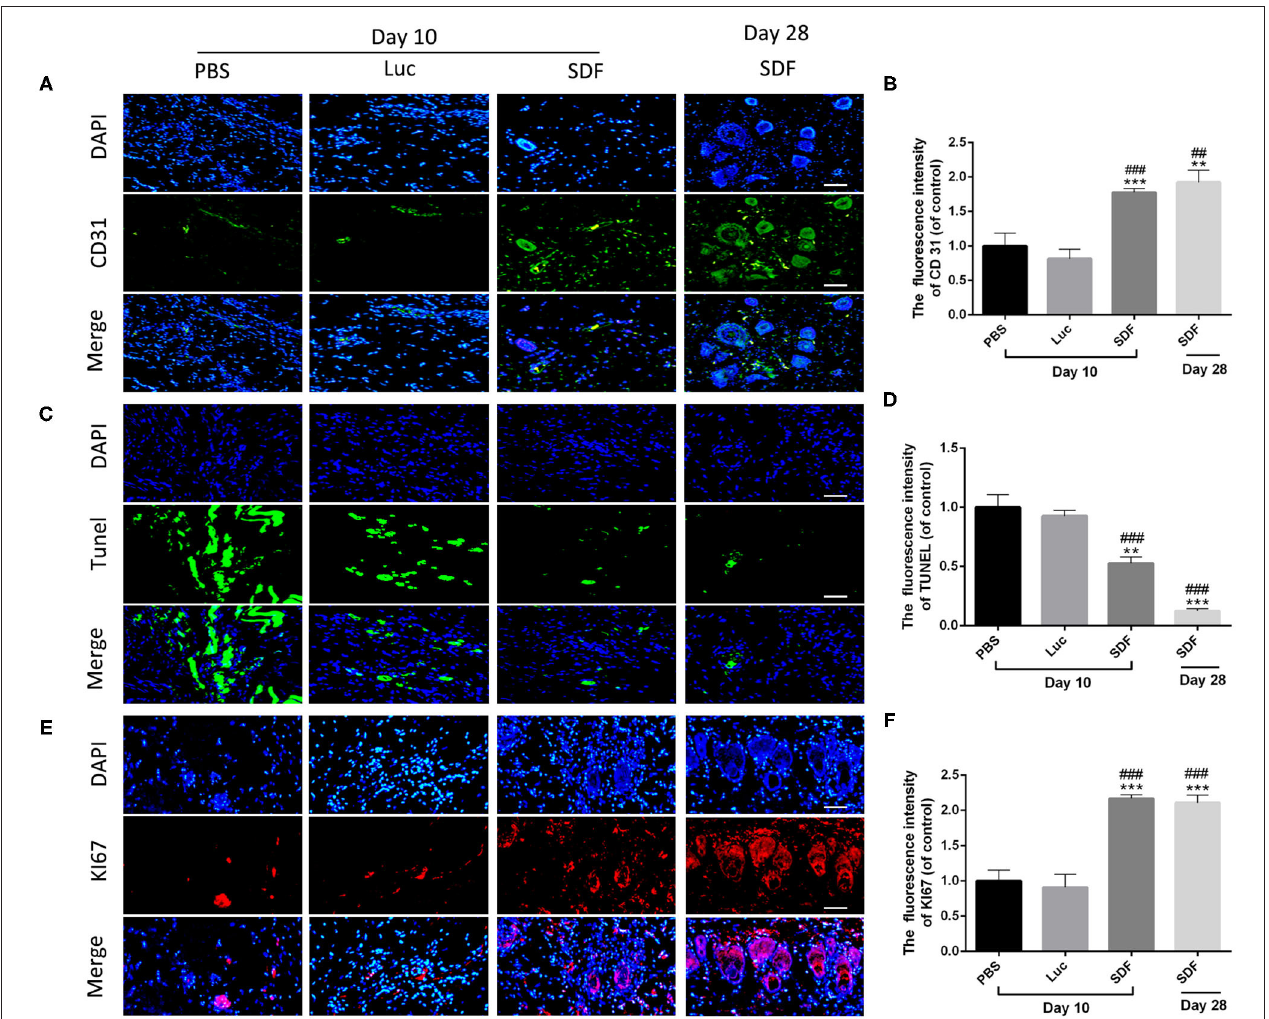
FIGURE 6 | SDF-1 α modRNA treatment promoted neovascularization and proliferation in the skin flap areas. Immunofluorescence staining of skin flaps of each group with (A) anti-CD31 antibodies (green) and DAPI (blue). (B) Quantification of immunohistochemical data (scale bar: 200 µ m). (C) Cell apoptosis assessed by TUNEL staining. (D) Quantification of TUNEL staining data (scale bar: 200 µ m). (E) Immunofluorescence staining of KI67 (red) and DAPI (blue). (F) Quantification of immunohistofluorescence data (bar: 200 µ m). Data represent the mean ± SD ( n = 4). ** P = (0.01–0.05), *** P < 0.01 vs. PBS; ## P = (0.01–0.05), ### P < 0.01 vs.